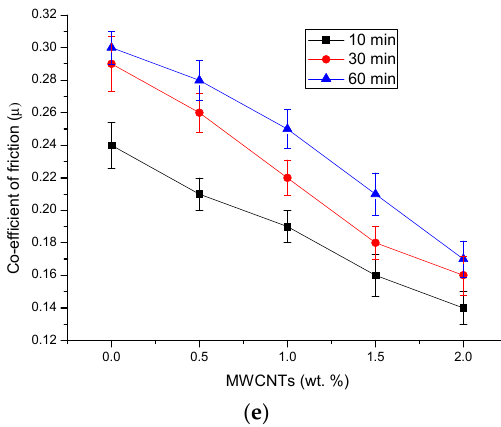
Figure 4. The sliding distance vs. wear volume of plasma treated samples ( a ) 10 min; ( b ) 30 min; ( c ) 60 min; ( d ) wear factor ( e ) coefficient of friction under dry test conditions.